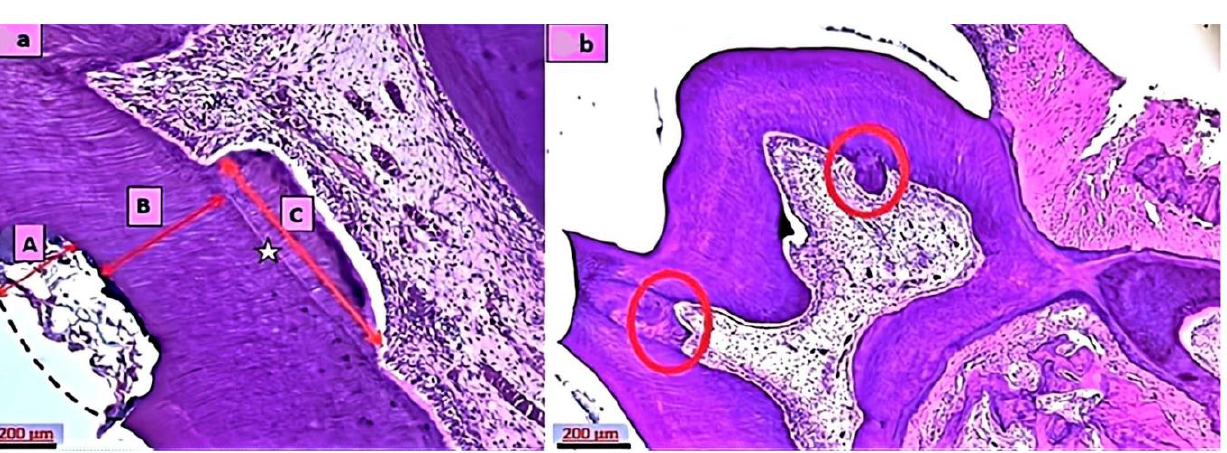
Table 2. Mean score and SD of dentin – pulp complex reaction for occlusal c-GIC and nano-HA-SiO 2 - GIC at each experimental time interval.